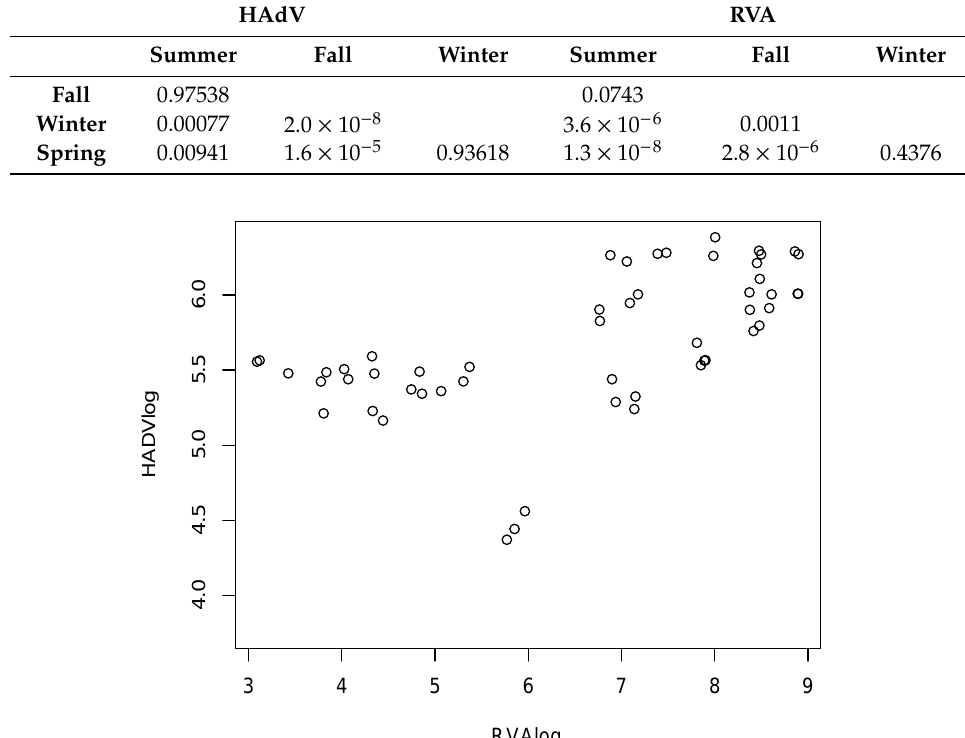
Figure 1. Correlation analysis between human adenovirus (HAdV) and rotavirus A (RVA) circulation in Catalonia. HAdV and RVA were detected and viral loads were estimated through qPCR (HAdV) and RT-qPCR (RVA) analysis of 42 mL raw sewage samples. The correlation analysis was performed using R software package.